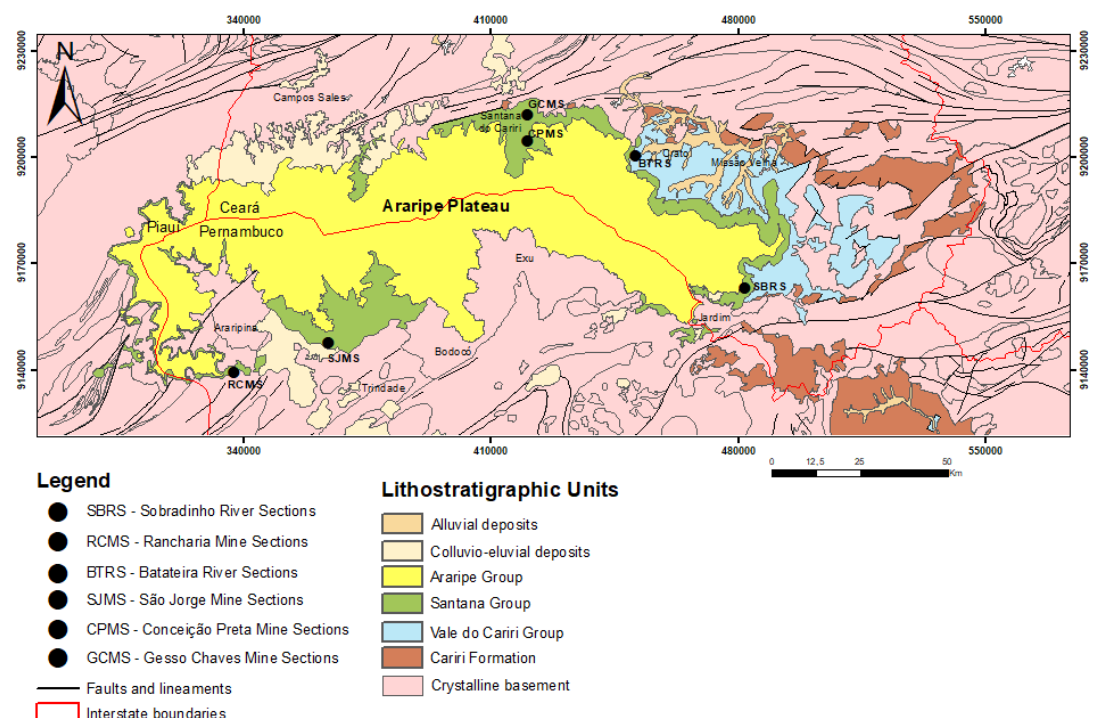
Figure 1. Geological map of the study area depicting the Araripe Plateau with the indication of major lithostratigraphic units and structural features. The black circles localize the Batateira River (BTRS), Sobradinho River (SBRS), Rancharia Mine (RCMS), São Jorge Mine (SJMS), Gesso Chaves Mine (GCMS), and Conceição Preta Mine (CPMS) sections analyzed in this research.